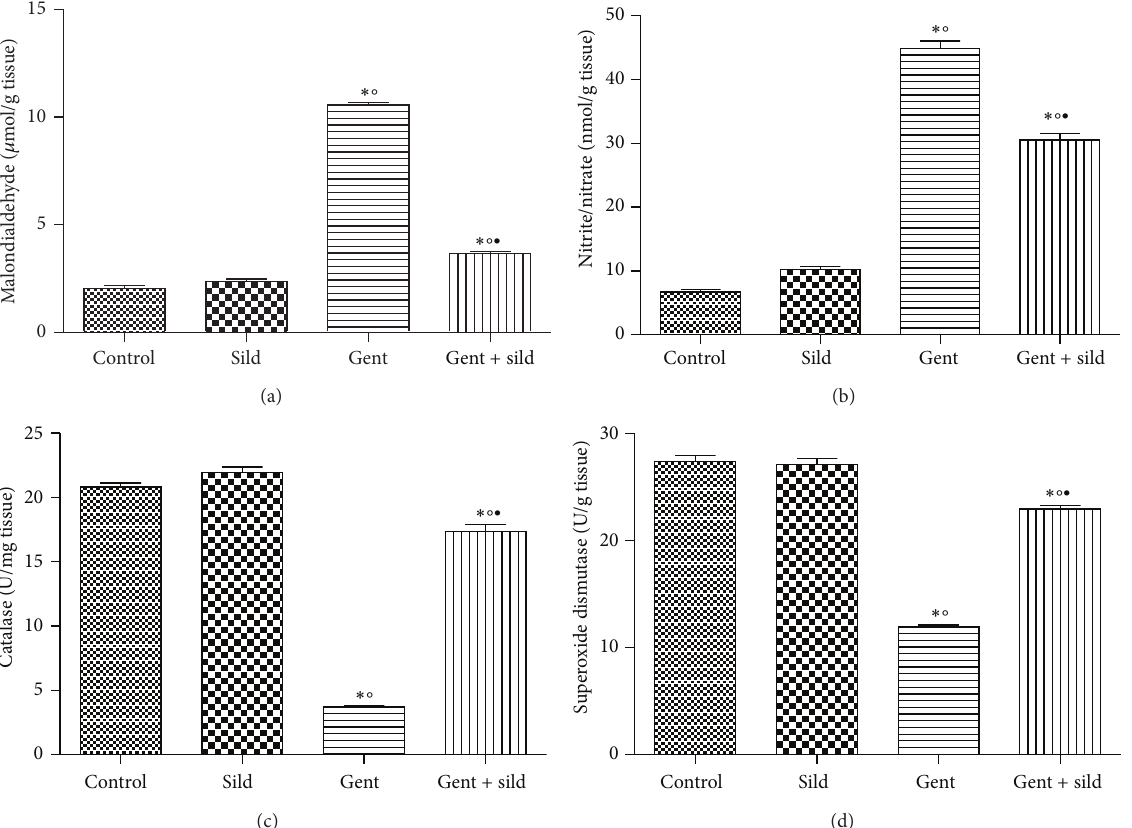
Figure 2: Effect of sildenafil (Sild) on renal malondialdehyde (a), nitrite/nitrate (b), catalase (c), and superoxide dismutase (d) levels of gentamicin- (Gent-)induced nephrotoxicity in rats. Data are mean ± SEM of 6–8 rats. ∗,∘,∙ Significantly different from control, sildenafil, and gentamicin groups, respectively, at 𝑃 < 0.05